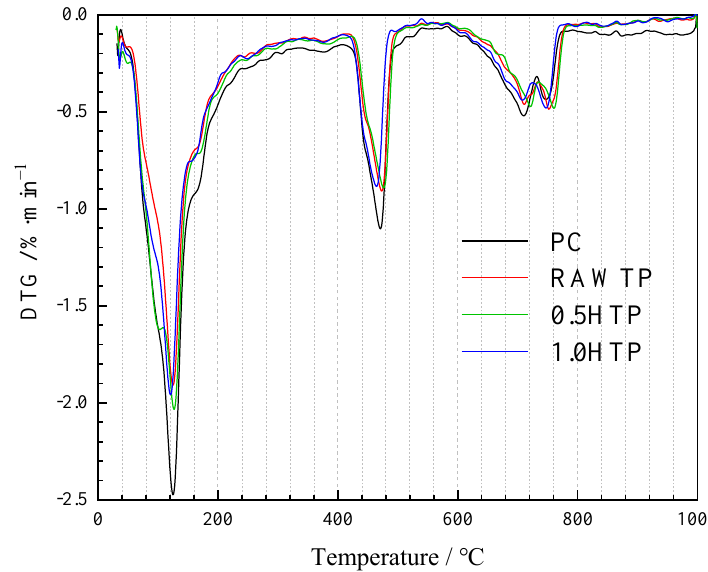
Figure 14. DTG result of cementitious pastes.